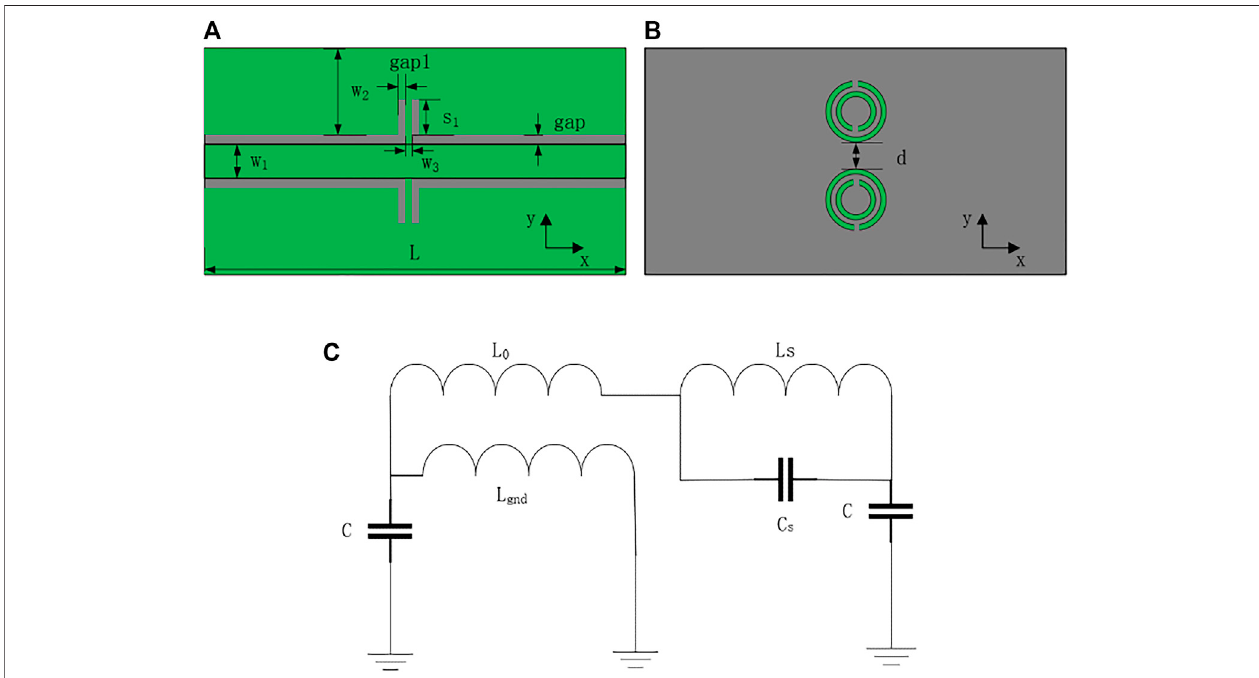
FIGURE 5 | Schematic diagram of bandpass fi lter based on SRR CPW structure. (A) The front side view (B) The back side view (C) Equivalent circuit of the SRR CPW structure.